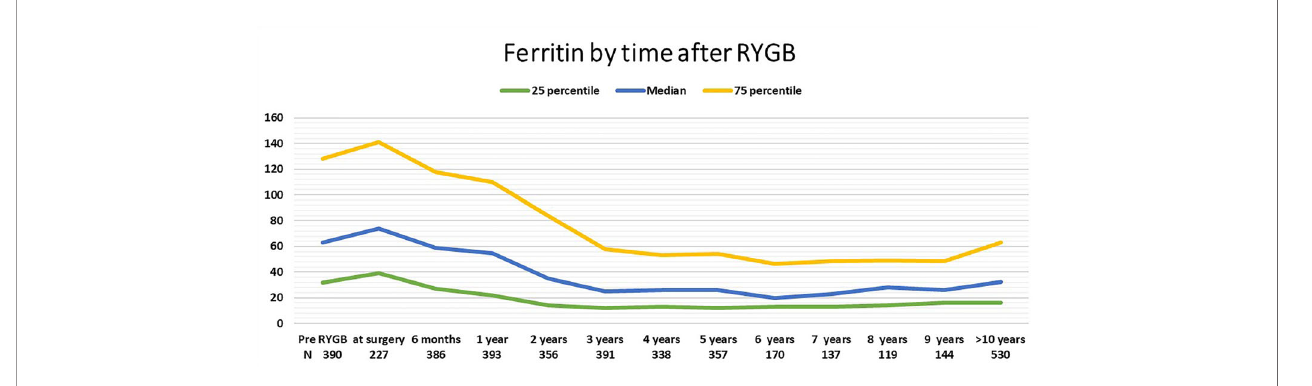
FIGURE 2 | Median and interquartile range of ferritin by time after RYGB.